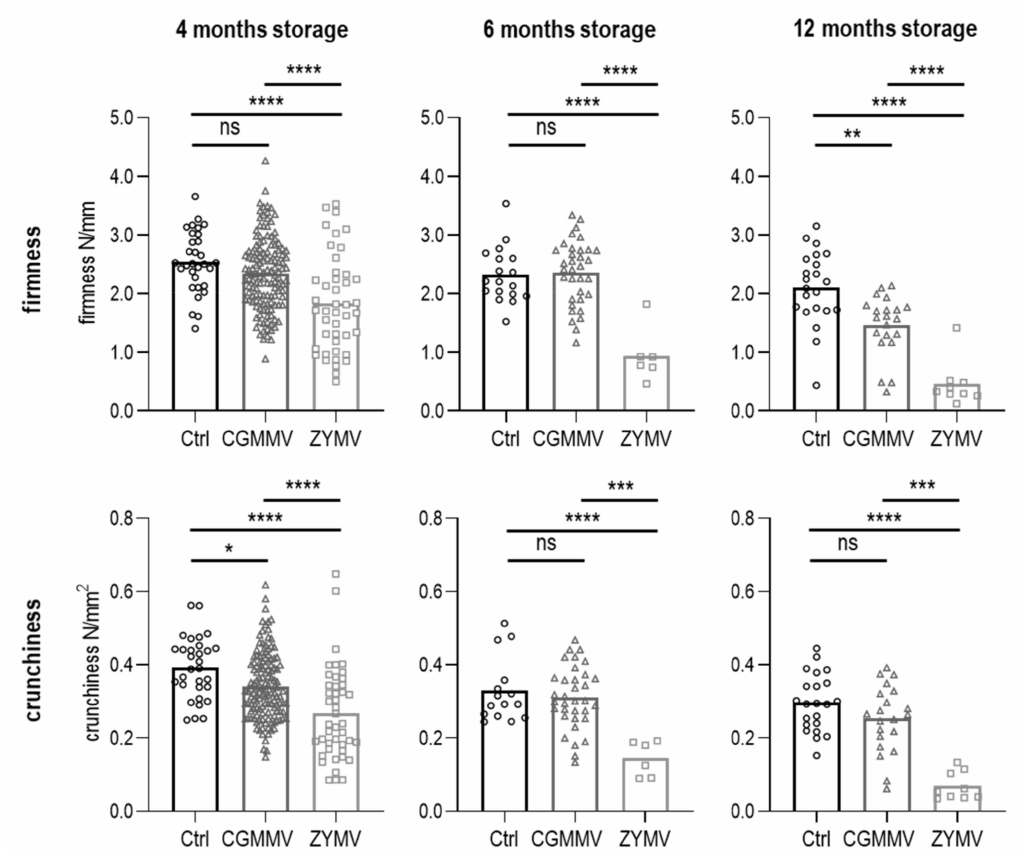
Figure 5. Crunchiness and Firmness of virus-infected and non-infected pasteurized C. sativus fruits stored for four, six and 12 months. The texture values of control fruits (Ctrl) and CGMMV-infected fruits are approximately the same magnitude, except for firmness after 12 months of storage. The texture values of ZYMV-infected pickles are consistently significantly lower than the values of control and CGMMV-infected fruits (ANOVA). The numbers of measured control fruits were as follows: after four months, n = 31, after six months, n = 18, after 12 months n = 22. The numbers of measured CGMMV- infected fruits were as follows: after four months, n = 133, after six months n = 34, after 12 months n = 21. The numbers of measured ZYMV-infected fruits were as follows: after four months, n = 44, after six months n = 6, after 12 months n = 9. ANOVA was performed with ns p > 0.05, * p ≤ 0.05, ** p ≤ 0.01, *** p ≤ 0.001, **** p ≤